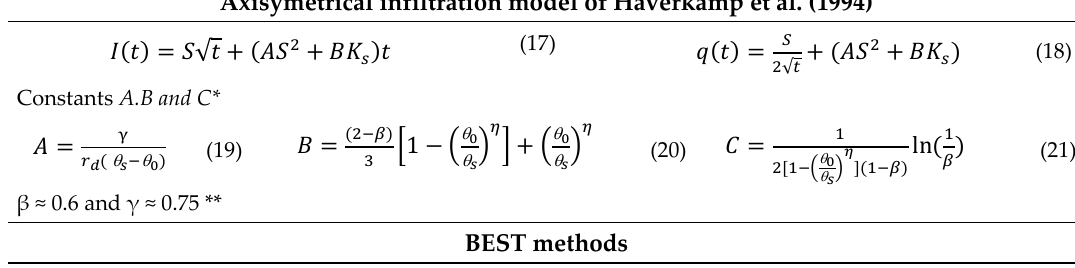
Table 2. Estimation of hydrodynamic parameters K s and S by the Beerkan estimation of soil transfer parameters (BEST) methods using the model of Haverkamp et al. (1994) [32]. Axisymetrical infiltration model of Haverkamp et al.